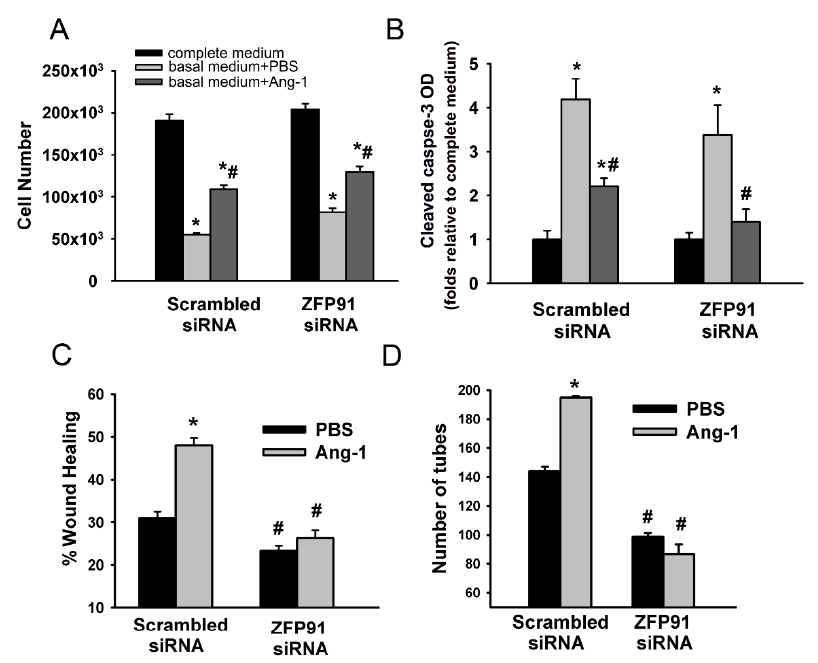
Figure 7. Effect of ZFP91 inhibition on Ang-1-induced angiogenesis. ( A and B ): HUVECs